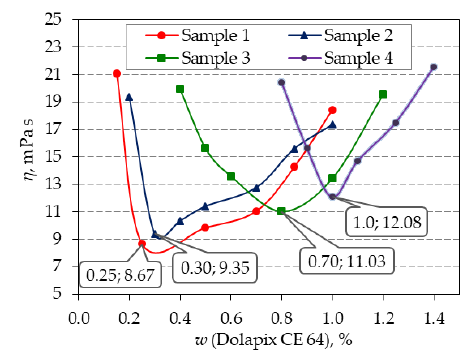
Figure 6. Influence of amounts of Dolapix CE 64 dispersant (wt. %) on apparent viscosity ( η ) of the 70 wt. % suspensions with ceramic powder composition of sample 1: 100 wt. % Al 2 O 3 ; sample 2: 99 wt. % Al 2 O 3 + 1 wt. % ZrO 2 ; sample 3: 95 wt. % Al 2 O 3 + 5 wt. % ZrO 2 ; sample 4: 90 wt. % Al 2 O 3 + 10 wt. % ZrO 2 .